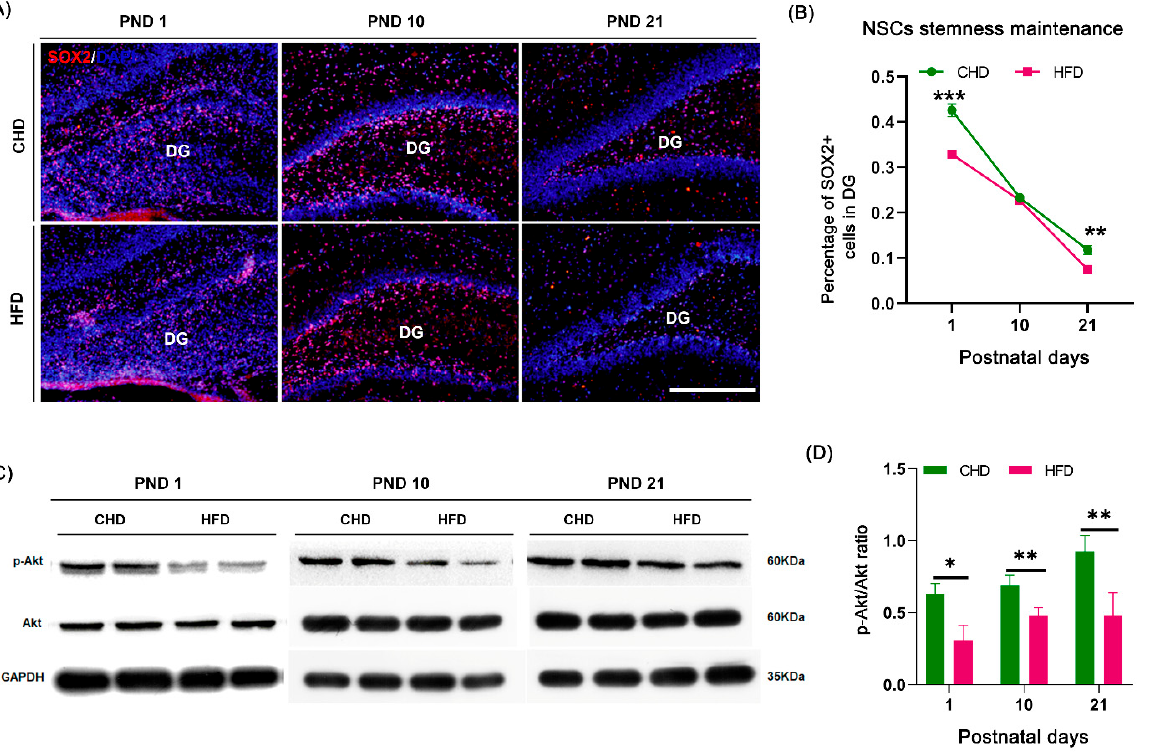
Figure 5. Maternal HFD affected NSC stemness maintenance during DG development. ( A ) SOX2 (red) immunostaining on PND 1, PND 10 and PND 21, scale bar = 50 μ m. ( B ) Quantification of NSC stemness maintenance (SOX2 + cells) on PND 1, PND 10 and PND 21 ( n = 3). ( C ) Western blotting of Akt and Akt phosphorylation in hippocampus on PND 1, PND 10 and PND 21. ( D ) Quantification of Akt phosphorylation to total Akt in hippocampus on PND 1, PND 10 and PND 21 ( n = 4). * p < 0.05, ** p < 0.01, *** p < 0.001 vs. CHD. DG, dentate gyrus; PND, postnatal day.